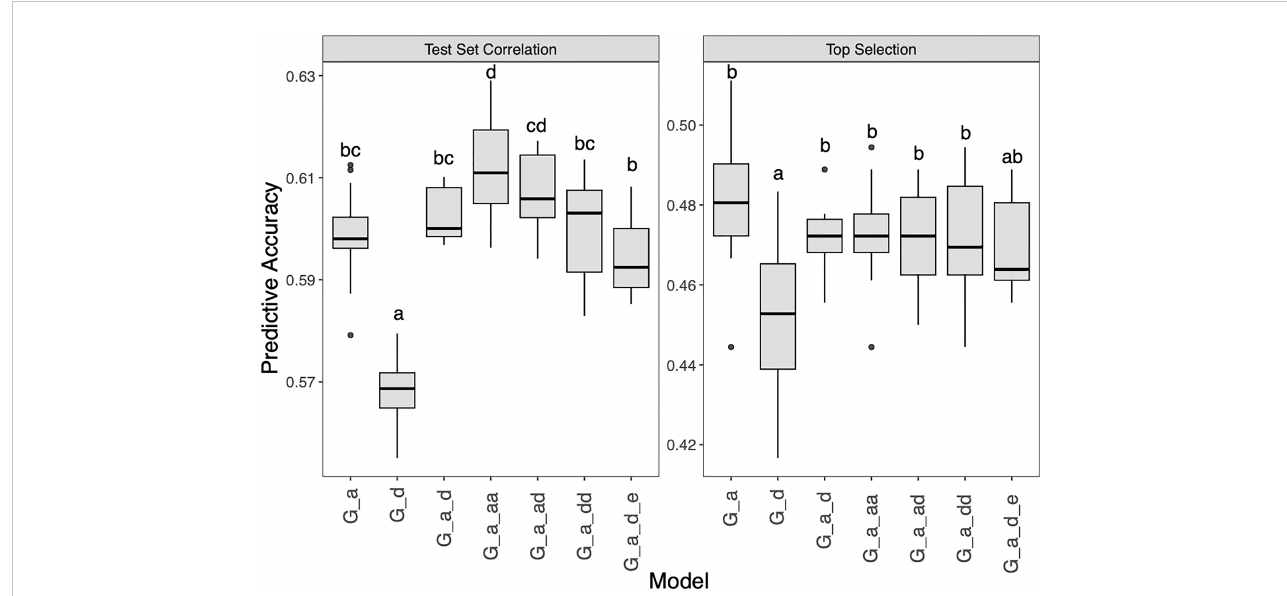
FIGURE 5 Genomic prediction study in hybrid panel with extend GBLUP models for Southern Corn Rust (SCR) resistance. The left is prediction accuracy for test set and the right is accuracy for top